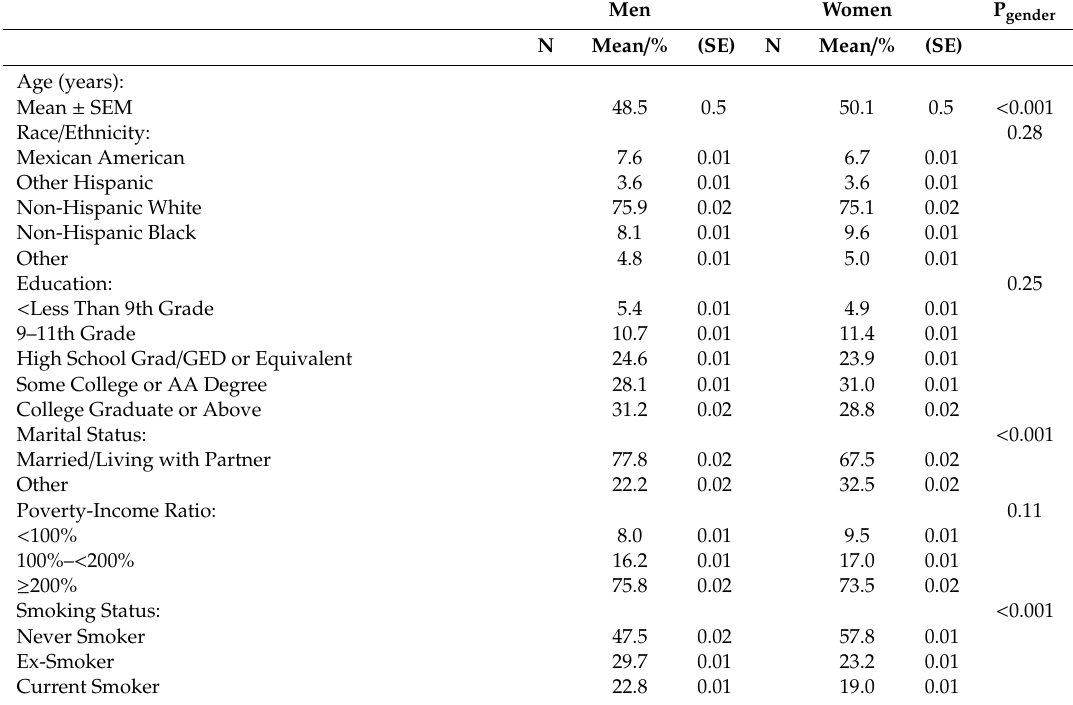
Table 1. Study sample characteristics by gender, the NHANES